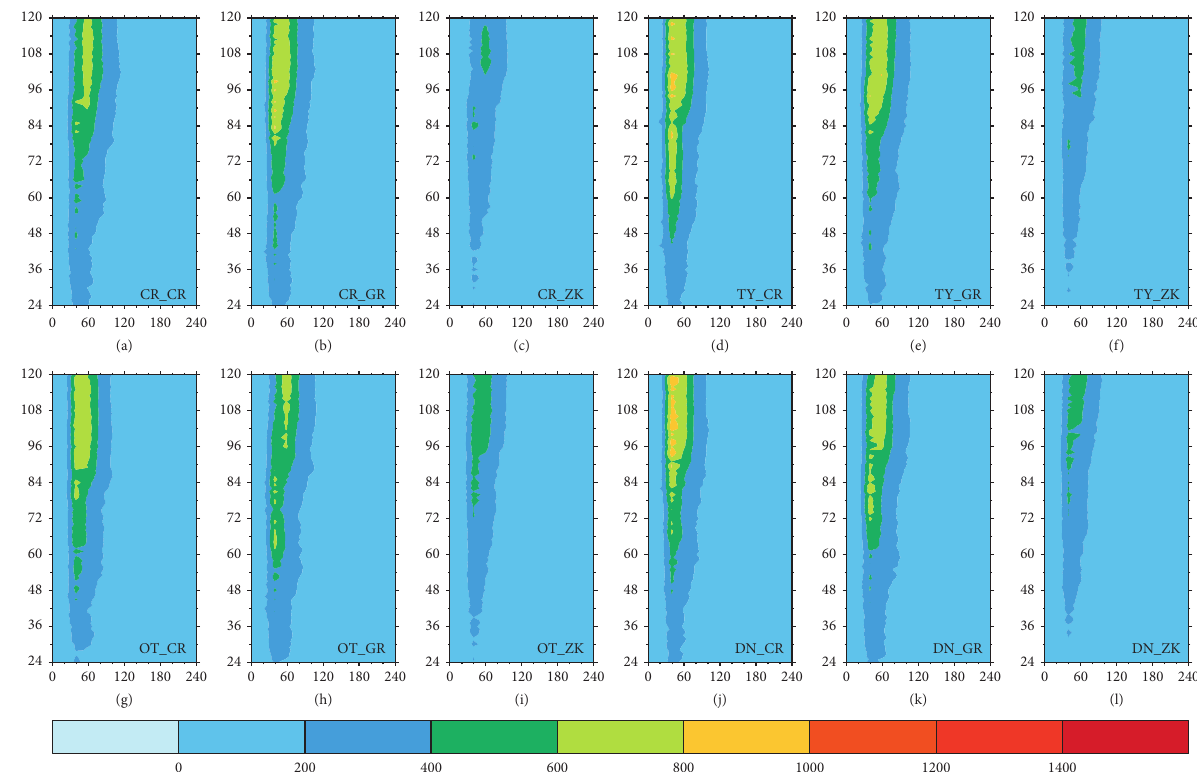
Figure 8: As in Figure 7, but for the azimuthally averaged sensible heat flux (W/m 2